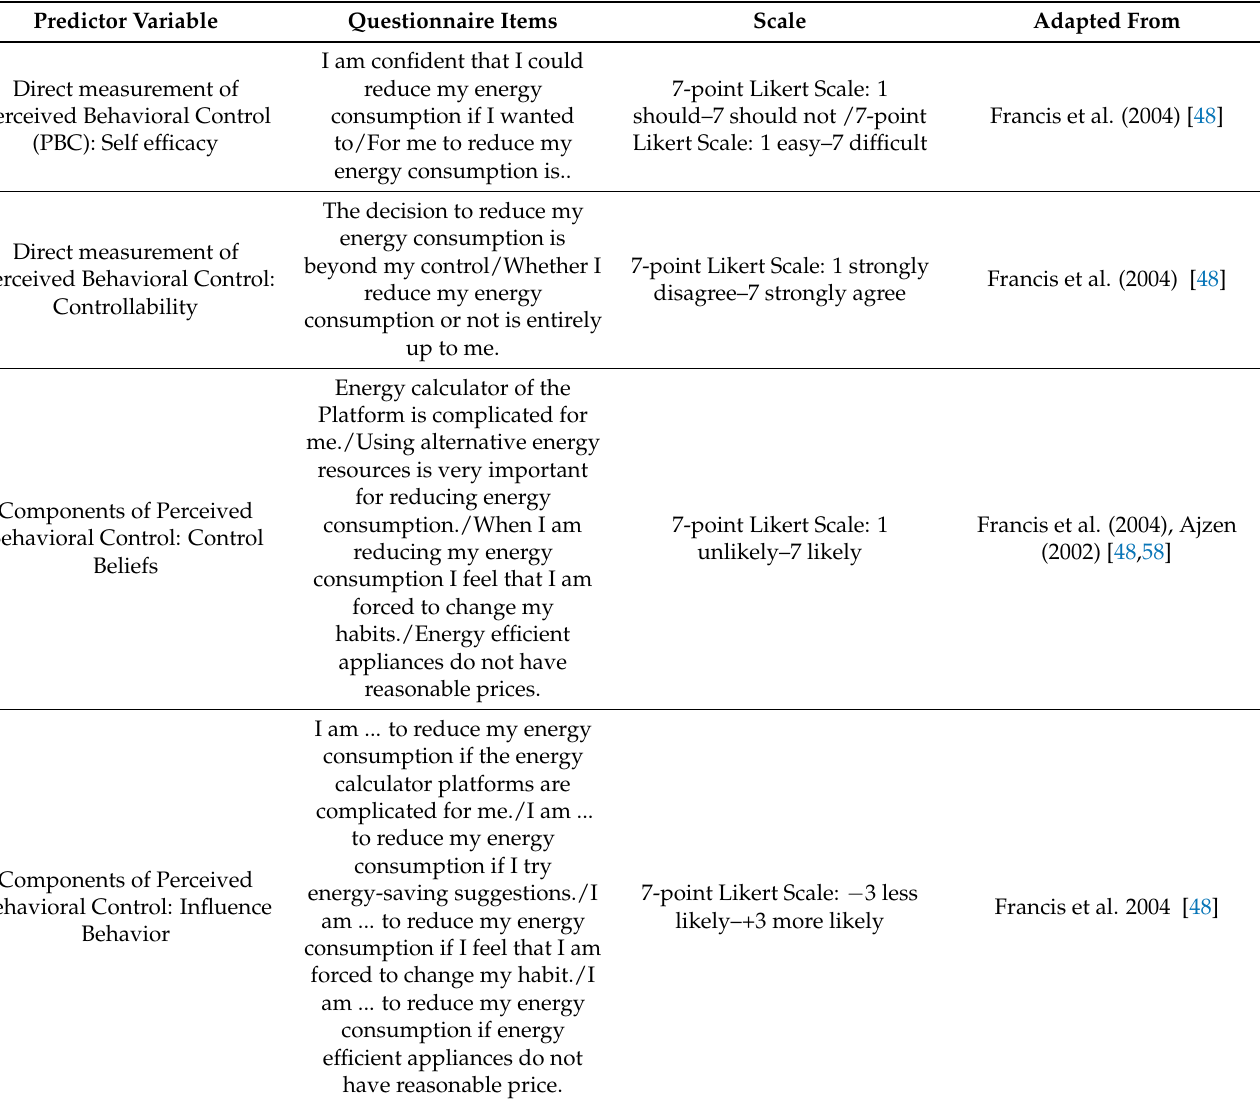
Table 4. Perceived Behavioral Control (the table was created by using resource of Ajzen and Fishbein (2005)